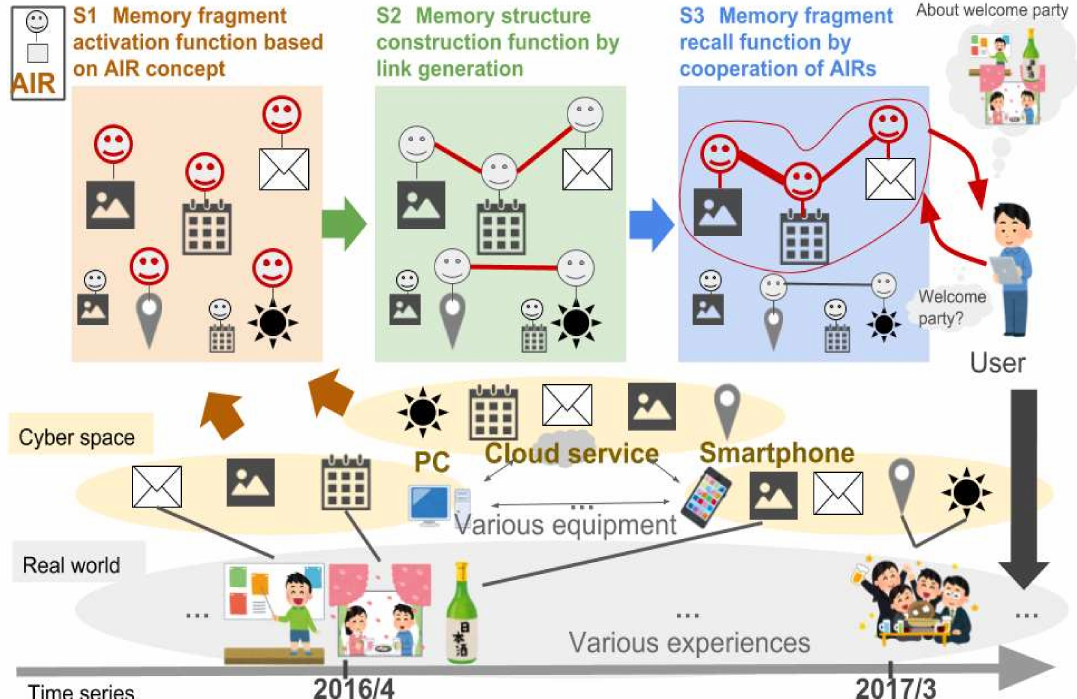
Figure 2. Overview of the proposed memory recall support system based on active acquisition and accumulation of memory